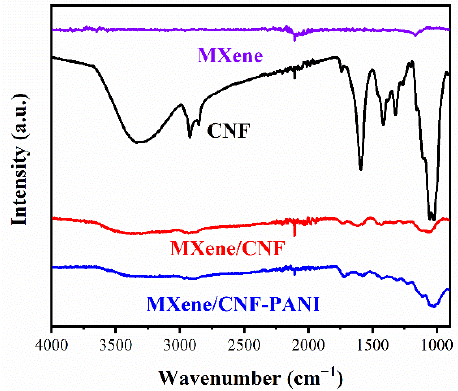
Figure 2. FTIR spectra of CNFs, MXene, MXene/CNF aerogel films and MXene/CNF–PANI aerogel